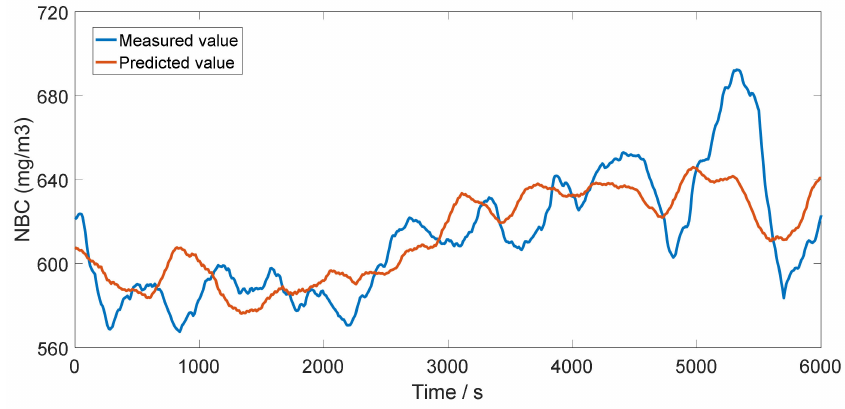
Figure 7. Trend of actual and predicted NO X value of 5000 t / d production line.